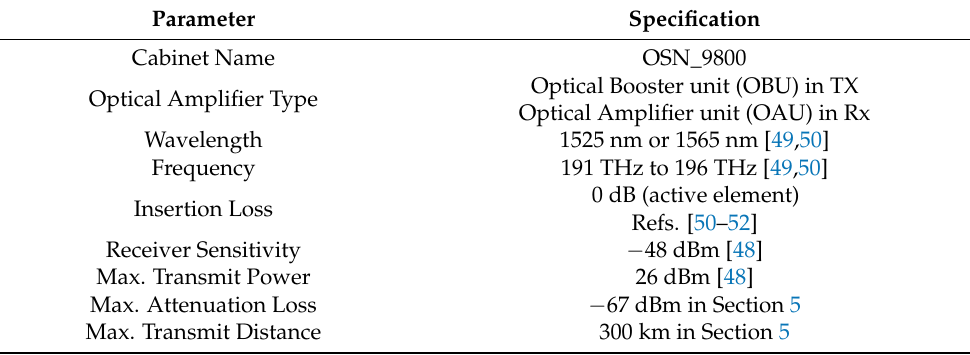
Table 3. The parameter of the EDFA optical amplifier board.